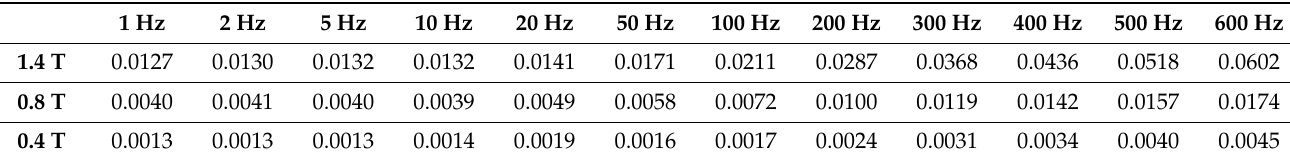
Table 2. Energy losses [J/kg] in function of frequency, obtained from simulations on amplitudes of B not involved in the training.